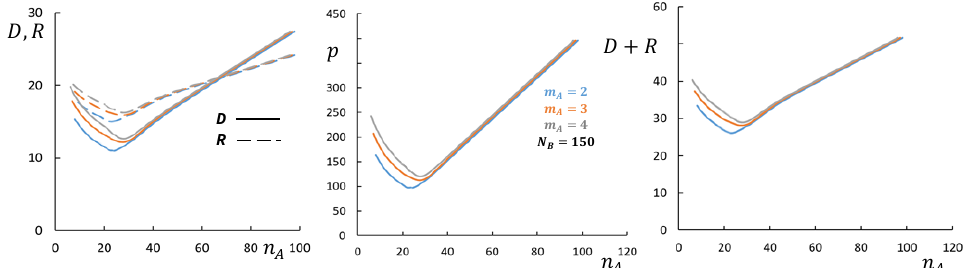
Figure 5. Aggregation number p , core radius R (dashed lines), and corona thickness D (solid lines), and overall radius, R + D , of micelles formed by block copolymers with N B = 150 and N A = 100 as a function of n A (cross-section (2) in Figure 3a). m A is varied, as indicated in the figure. Other parameters are q A = 1, γ = 1, v = 1, φ B =